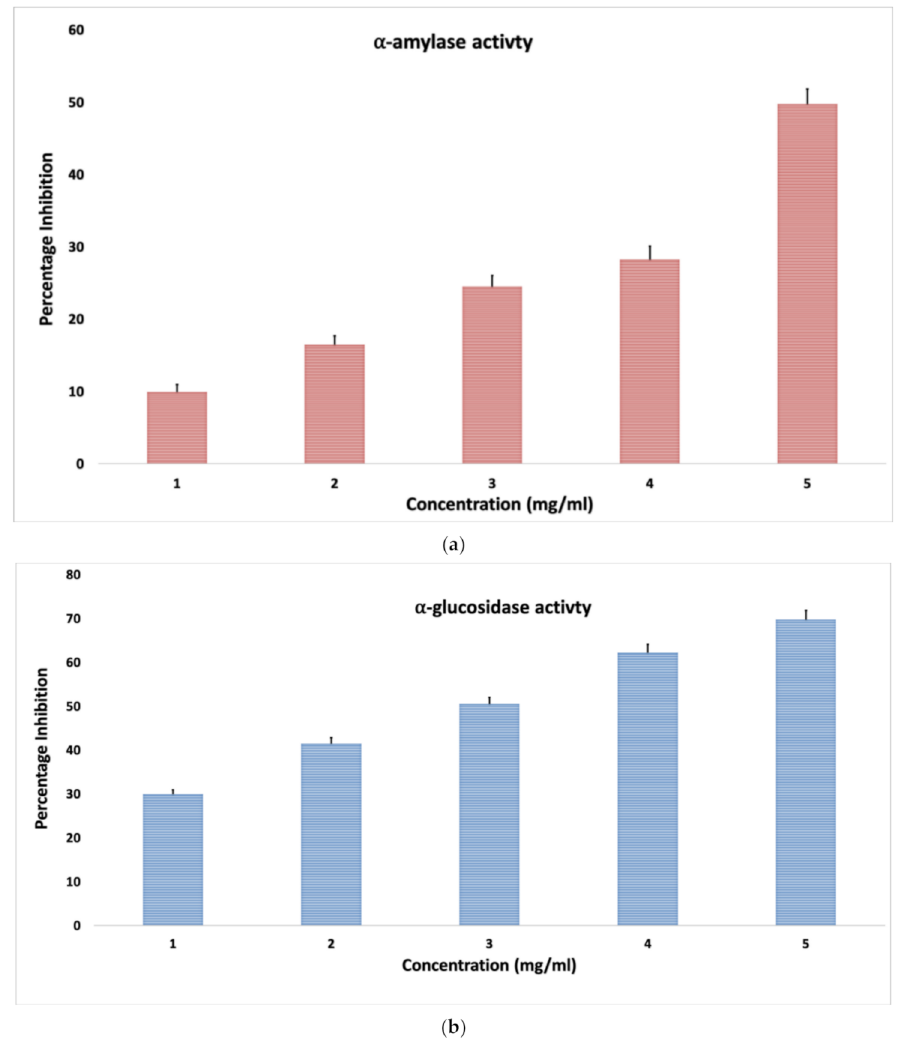
Figure 4. Screening of ( a ) α -amylase inhibitory assay, ( b ) α -glucosidase inhibitory assay of okra mucilage biopolymer at various concentrations. All experiments were performed in triplicate, and data are expressed as mean ± standard